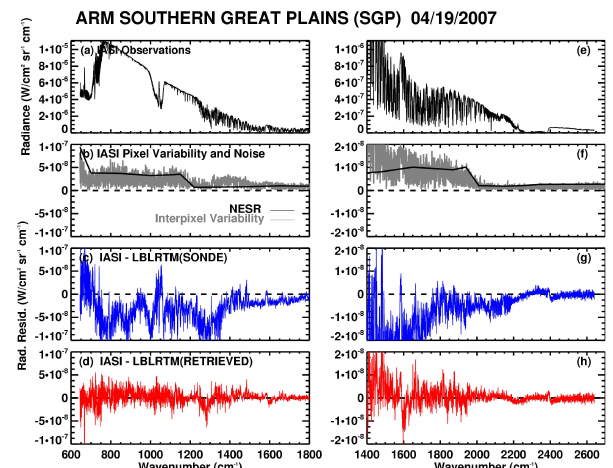
Fig. 6. (a, d) IASI measured spectrum in radiance for the land case. (b, e) Spectra showing the variation within the four pixels averaged to obtain the measurement vector. (c, f) IASI/LBLRTM compari- son for full IASI wavenumber range with initial guess input. (d, g) Comparison after retrievals of atmospheric temperature, H 2 O, O 3 , CH 4 , CO, OCS and HNO 3 . Note different scales on left and right in order to better present the lower radiance at the higher wavenum- bers.